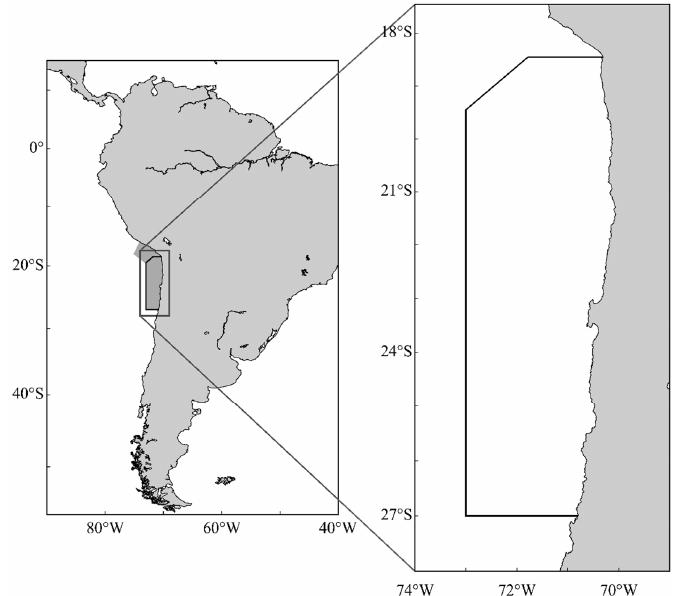
Figure 1. Stock of anchovy ( Engraulis ringens ( E. ringens )) distributed from Southern Peru to Northern Chile (16°–27° S). The right panel indicates the distribution of E. ringens in Northern Chile that is the study area covered by a neural network model applied to predict E. ringens fishing grounds.